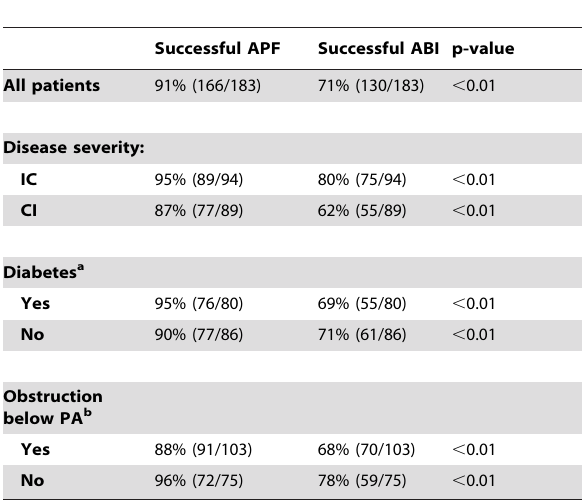
Table 2. Success rates of APF and ABI